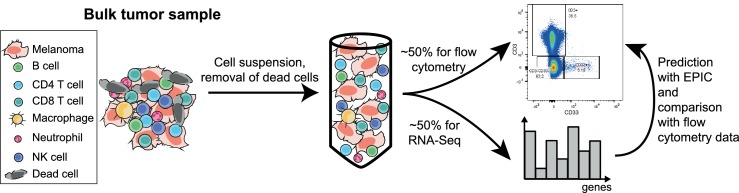
Sketch of the experiment designed to validate EPIC predictions starting from in vivo tumor samples.